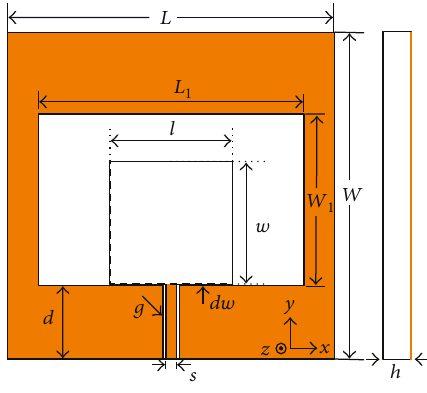
Figure 5: Antenna con fi guration.